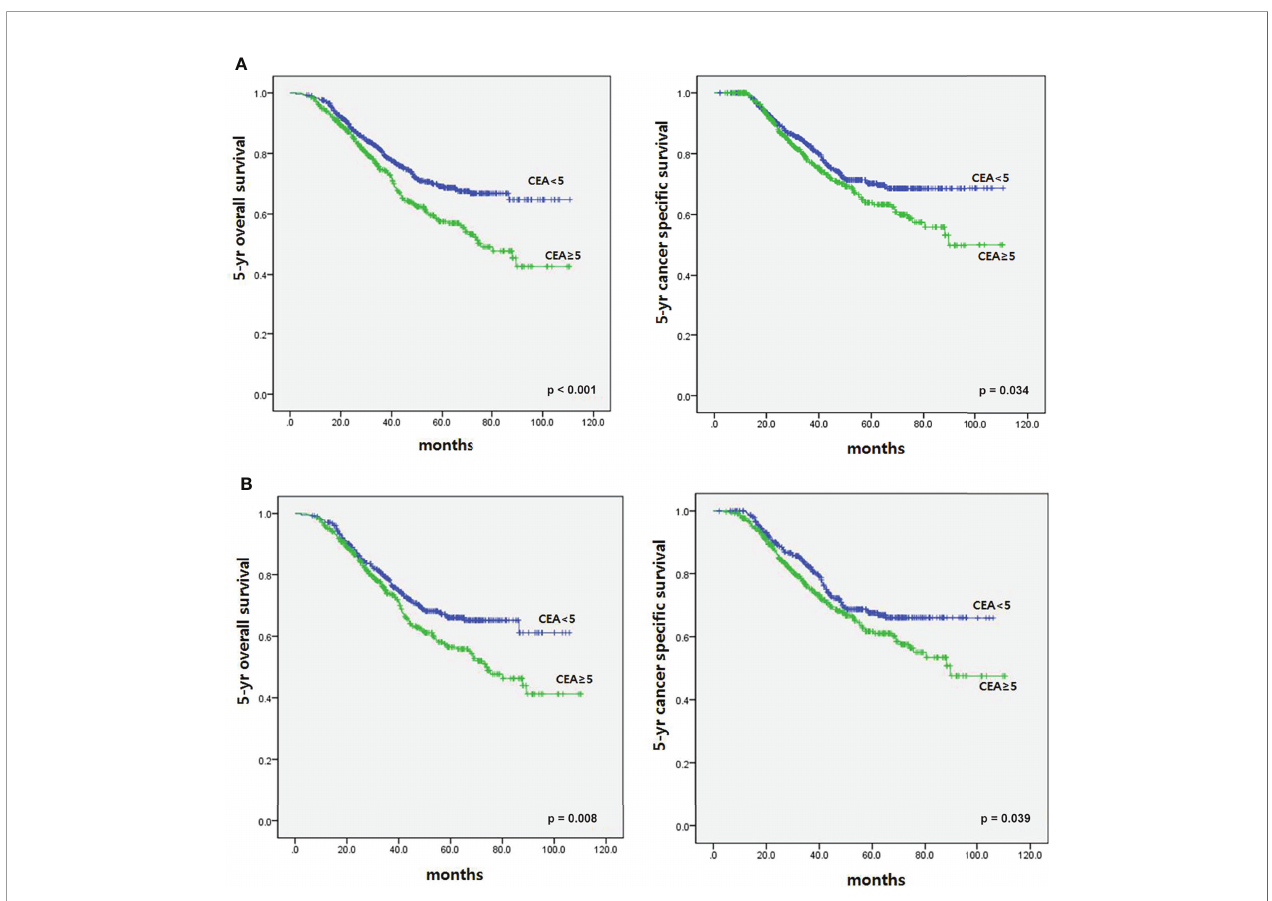
FIGURE 2 | Survival according to CEA level at the time of recurrence before and after matching. (A) Before matching. (B) After